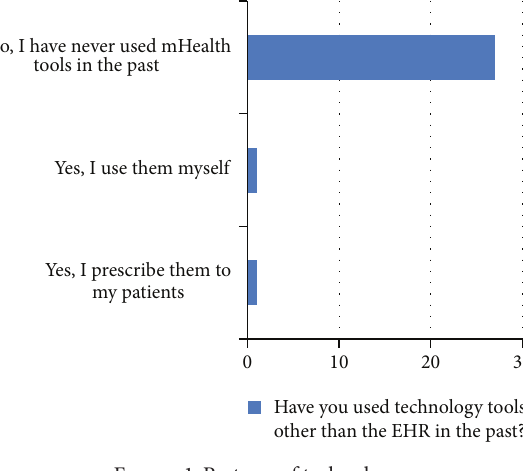
Figure 1: Past use of technology.